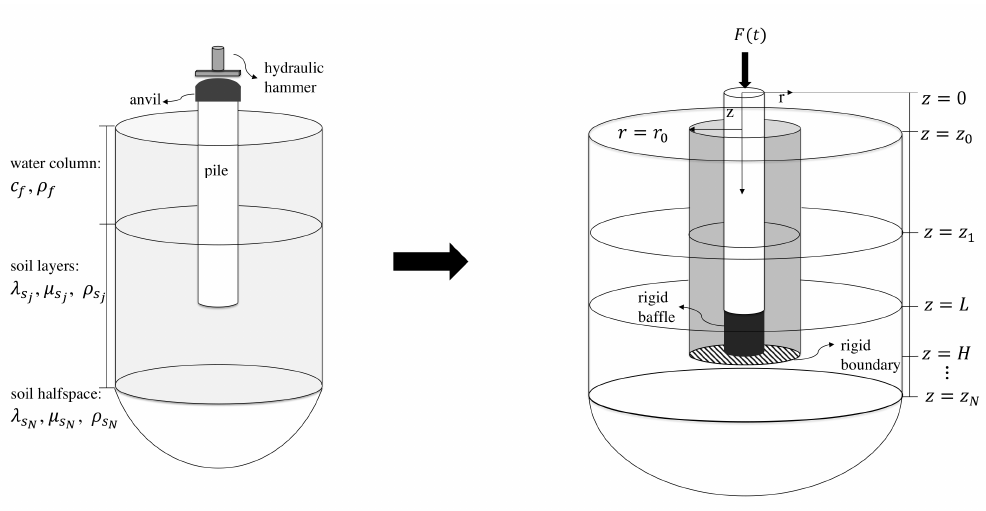
Figure 5. ( Left ) Representation of the actual pile–water–soil system with the hydraulic hammer and the anvil positioned at the pile head. ( Right ) Vibroacoustic model to predict noise from impact piling in which the hammer-anvil system is substituted by a force at the pile head [140]. The close-range module is marked in grey colour ( r ≤ r 0 ). The region outside the grey-shaded volume defines the far-range module ( r ≥ r 0